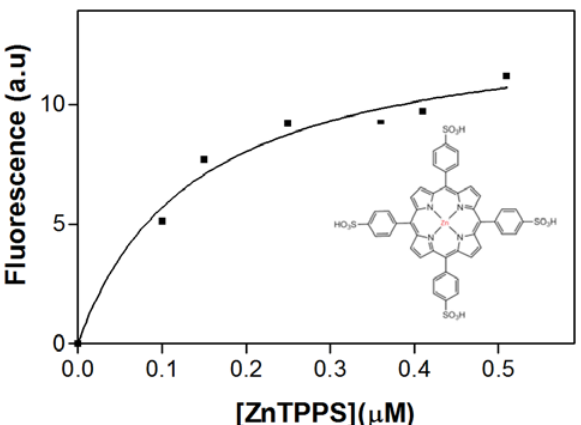
Fig. 2. Formation of Con A-ZnTPPS complexes, studied by means of intrinsic protein fluorescence (λ =295 nm) (inset-structure of 5,10,15,20-Tetrakis- exc (4-sulfonatophenyl)porphyrin-zinc (II))